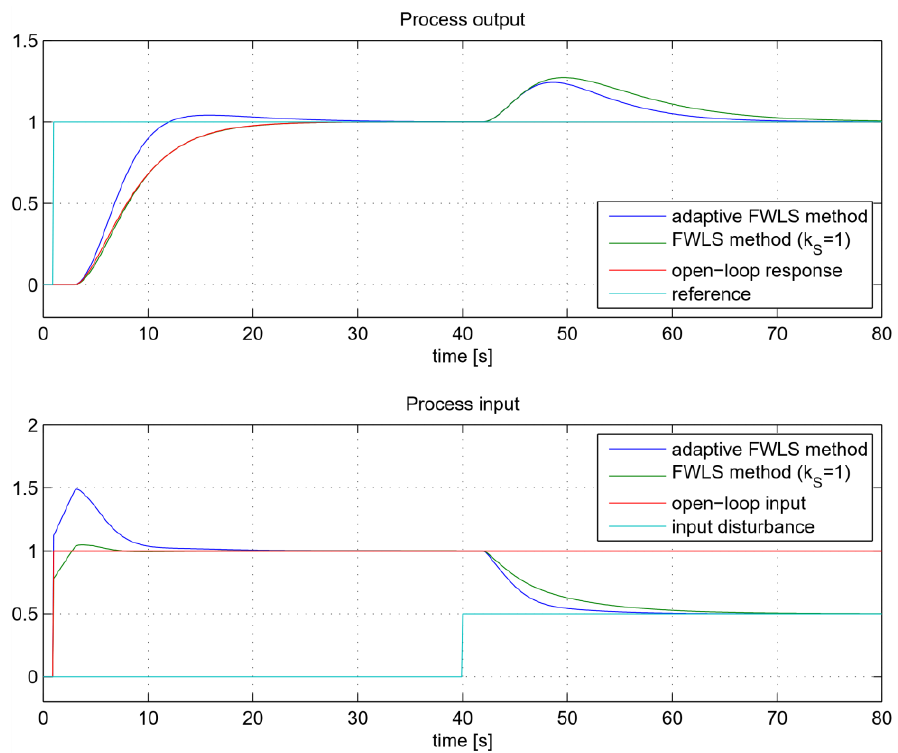
Figure 18. The closed-loop tracking and control signals for process G P 2 .